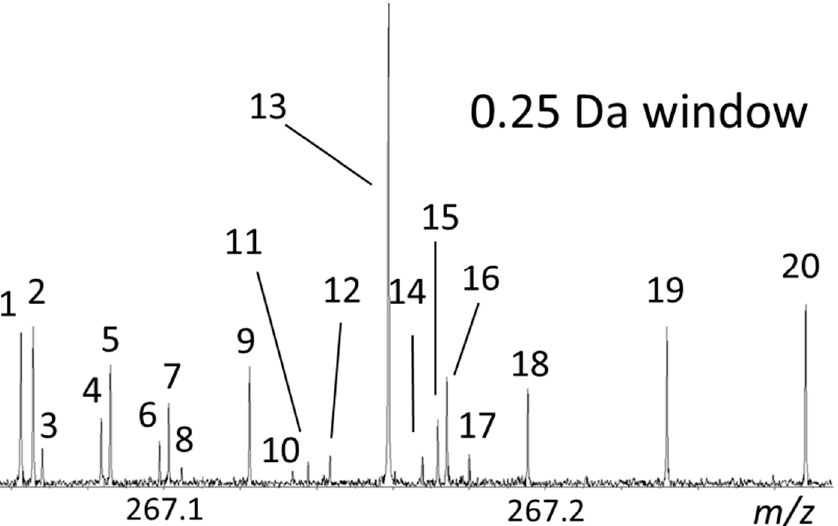
Figure 6. Mass-scale-expanded segments (0.25 u) of lignin broadband mass spectra. Reprinted from Qi et al. with permission from Elsevier [43].